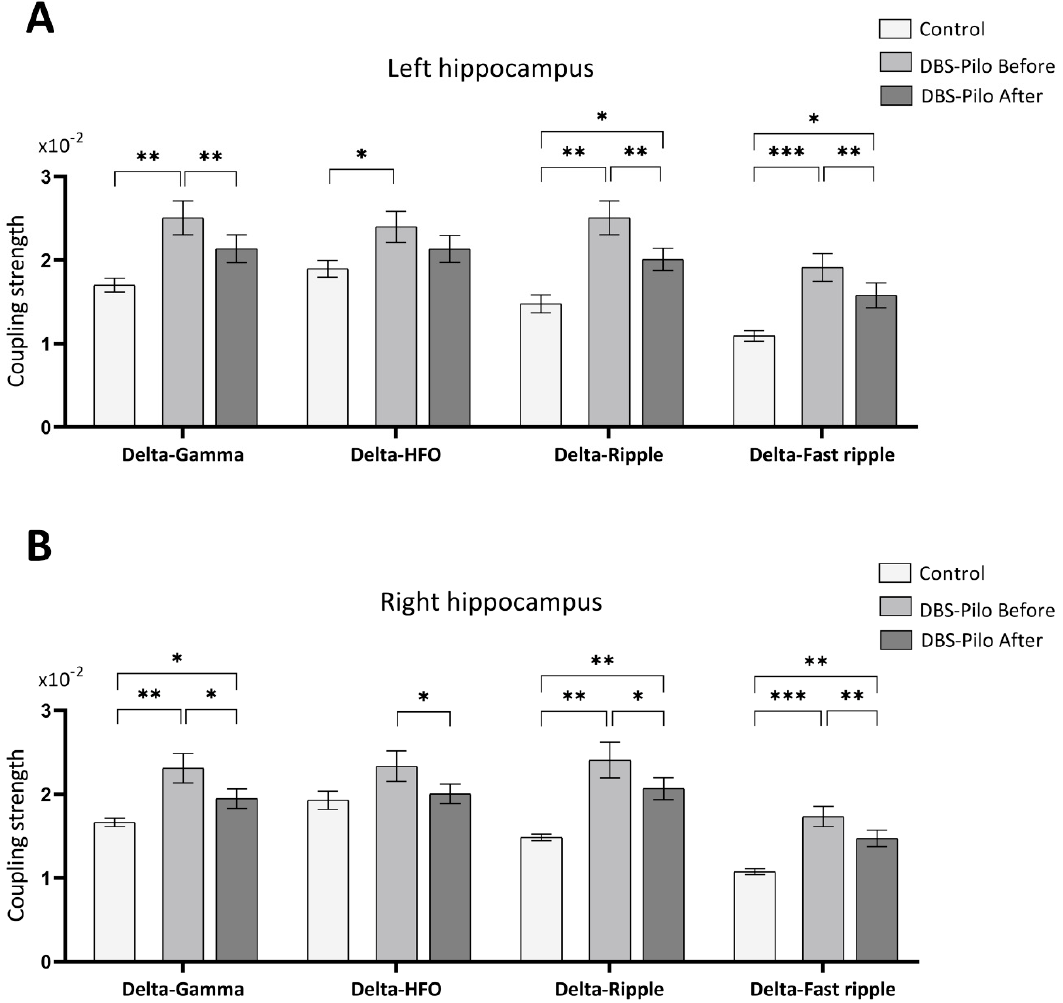
Figure 6. Representative comodulograms of phase-amplitude coupling (PAC) of individual animals showing the PAC strength between delta and fast-ripple frequency pairs. The coupling strength is color-coded (scale bar on the right). ( A ) The PAC comodulogram of the control animal is from a SHAM-Control rat. ( B ) The epileptic animals exhibited a stronger MaxPAC (white circle) which ( C ) was reduced after deep brain stimulation.